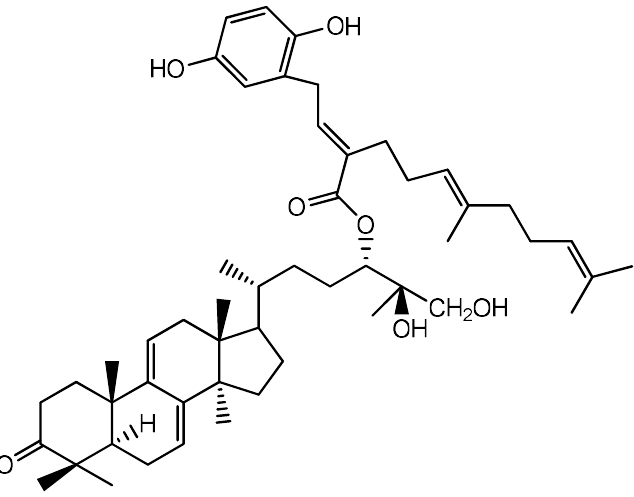
Figure 1. GL22 Ganoderma lucidum triterpene.